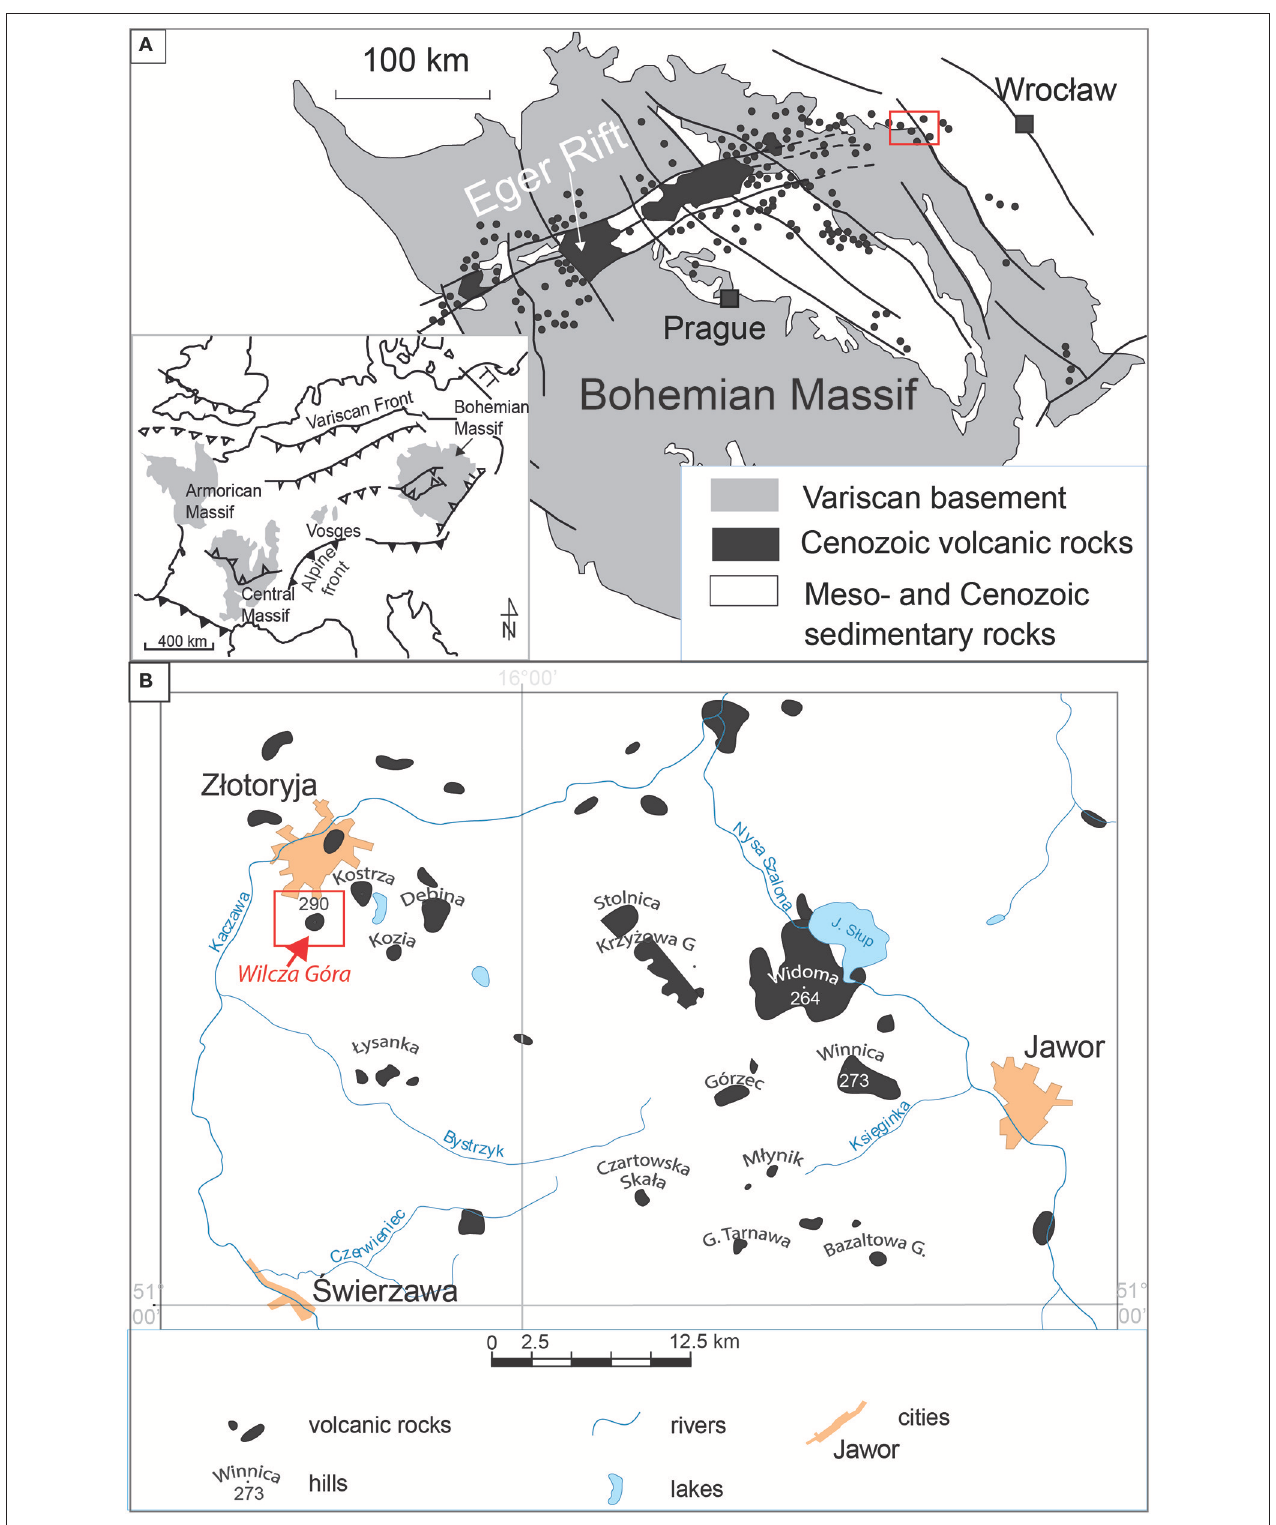
FIGURE 1 | (A) Location of Eger Rift in Bohemian Massif (based on Ulrych et al., 2011), inset shows European Variscan Basement and major fault zones (Mazur et al., 2006, modified); (B) Outcrops of Cenozoic volcanic rocks in the vicinity of Złotoryja city, location of Wilcza Góra indicated by arrow and red box (based on Sawicki,